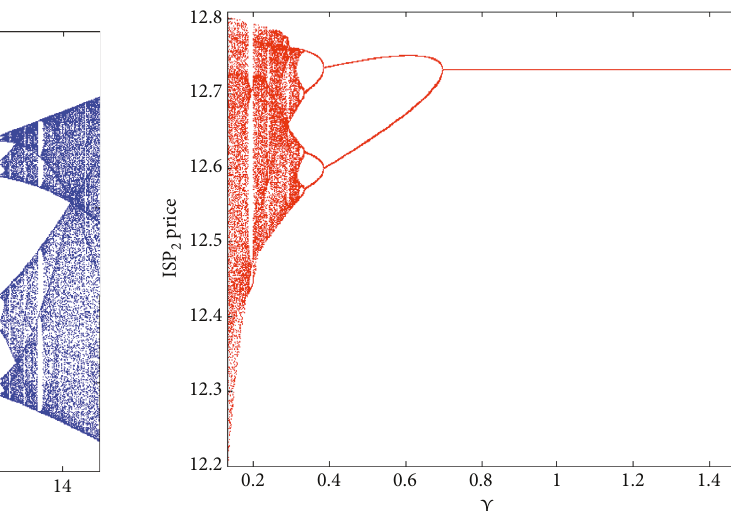
with respect to Υ 2